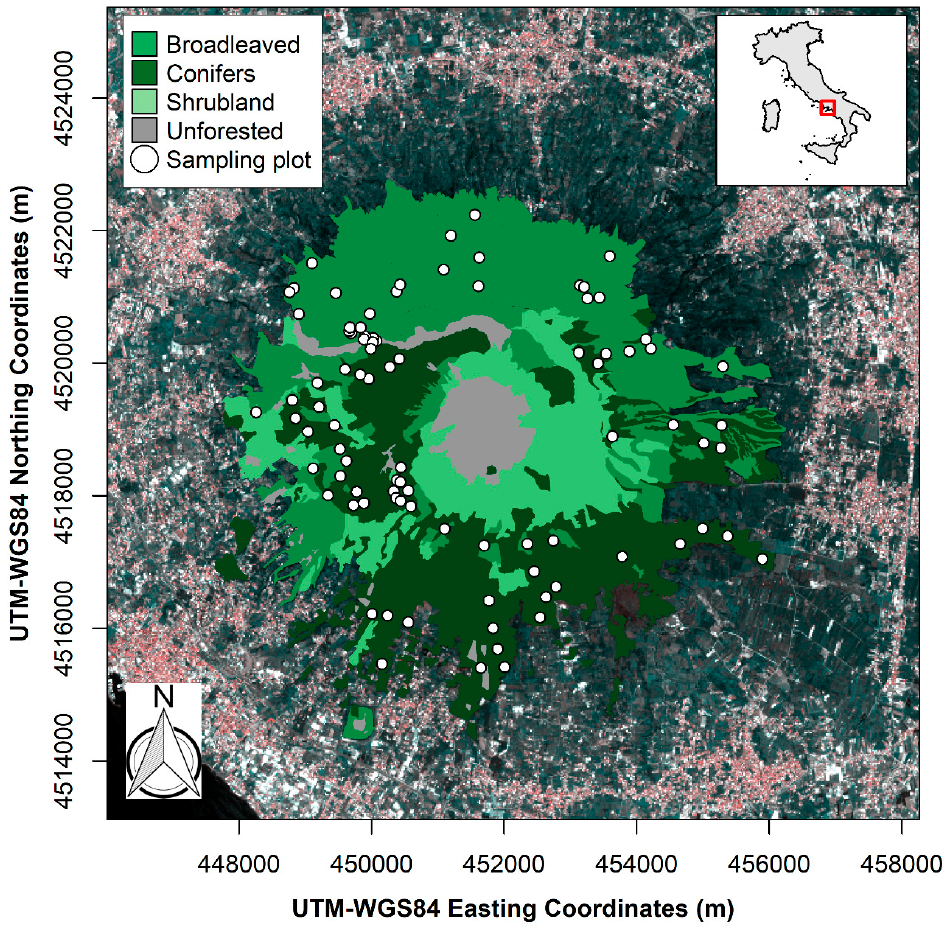
Figure 1. The two major forest categories (Mediterranean conifer and broadleaf) and broom shrublands (mainly the non-native and invasive Genista aetnensis and the native Cytisus scoparius ) in the Vesuvius National Park. The markers indicate spatial distribution of circular sampling plots (n = 90). The wavy grey area represents the lava flow during the 1944 eruption, and colonized by the endemic lichen Stereocaulon vesuvianum . The National Park perimeter is encircled by a highly densely populated area.